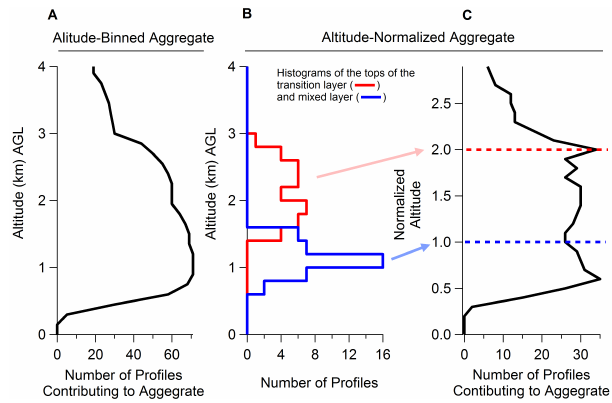
Figure 2. (a) The number of profiles that contribute to the altitude- binned aggregate, (b) histograms of the altitude of the tops of the transition and mixed layers, and (c) the number of profiles that con- tribute to the altitude-normalized